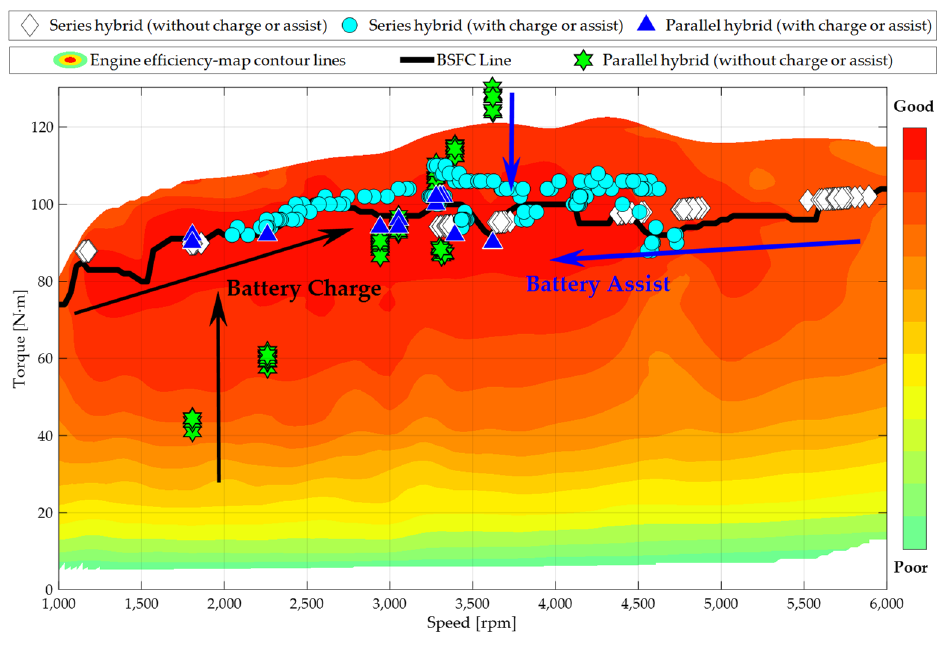
Figure 3. Mode shifting and engine operating point.